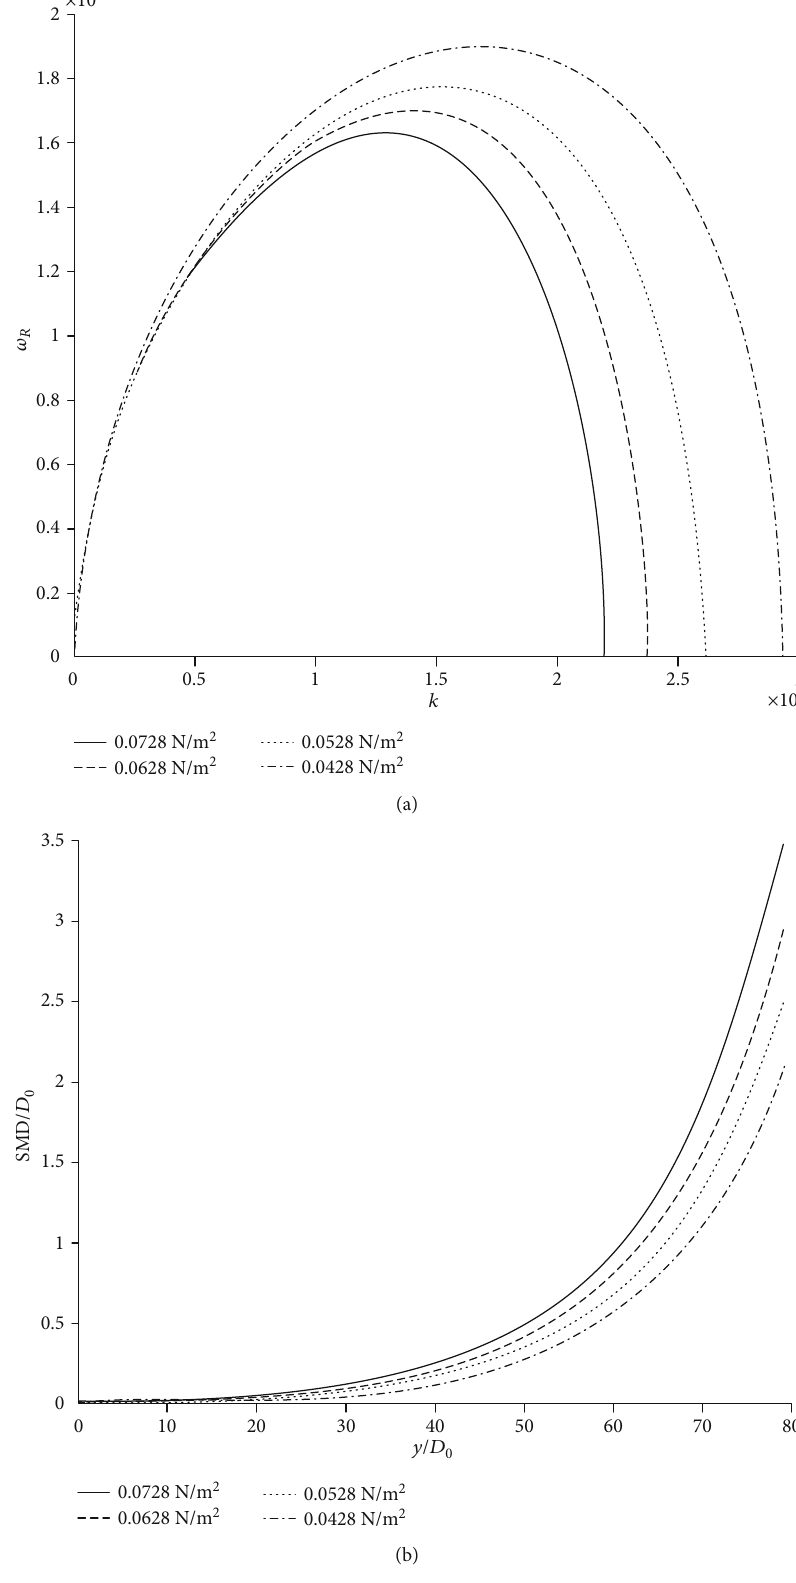
Figure 8: E ff ect of surface tension to (a) surface wave growth rate and (b) droplet size distribution ( ρ = 37 : 98m/s , u = 13 : 39m/s , and q = 96 : 35 L